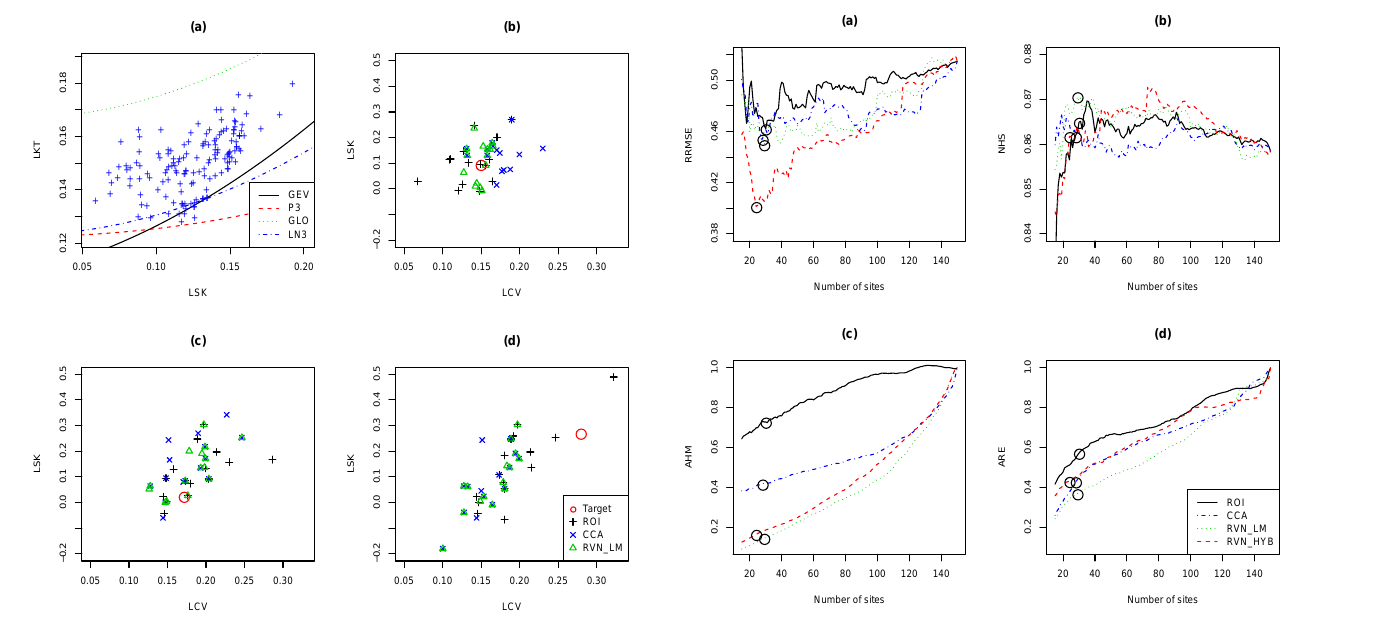
Figure 5. L-moments ratio diagram for index-flood model. (a) Re- gional L-moments for RVN-LM with 29 gauged sites. (b, c, d) Re- gional L-moments based on the 15 nearest gauged sites for 3 se- lected target locations.